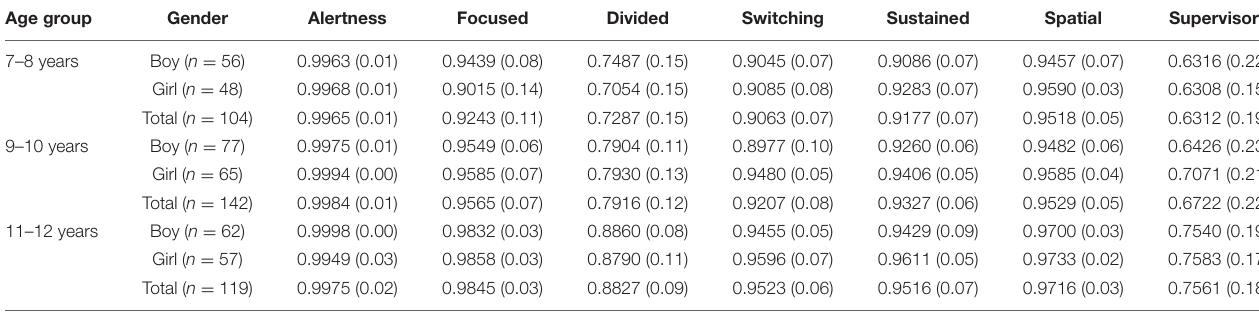
TABLE 2 | Accuracy in the seven tasks across the three groups.